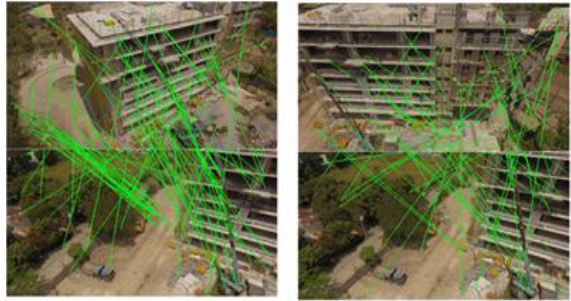
Figure 5. Image to image matching using SIFT